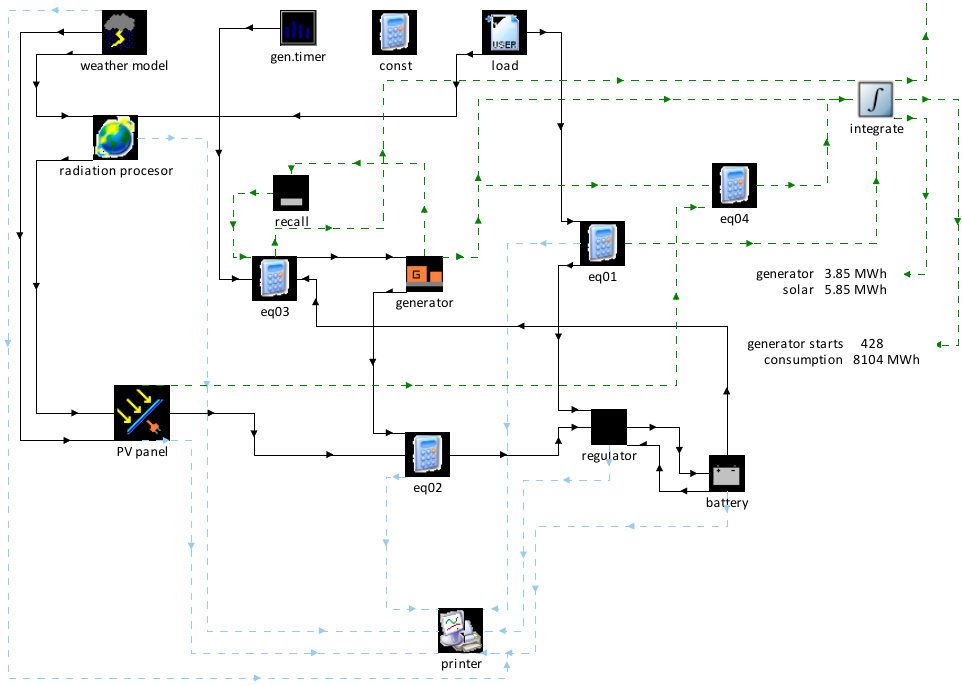
Figure 11. System configuration in TRNSYS software environment for the simulations.